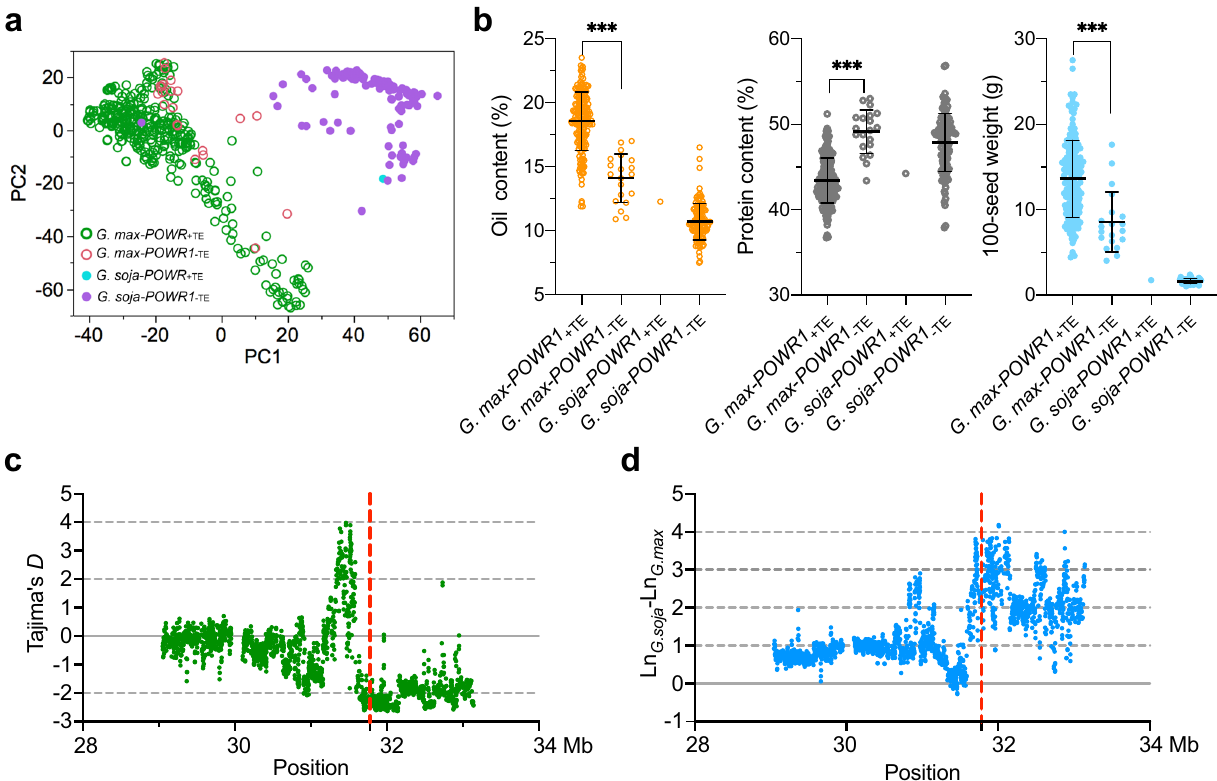
Fig. 4 Distribution and diversity analysis of POWR1 alleles in soybean. a PCA of 548 cultivated and wild soybean accessions with different allele types is shown. b Comparison of seed oil and protein content and 100-seed weight of G. max and G. soja accessions carrying POWR1 + TE or POWR1 − TE ( n = 377; 21, 1,149). Statistical signi fi cance was determined by two-tailed unpaired Student ’ s t test. * p < 0.05, ** p < 0.01, and *** p < 0.001. Unpaired t -test p values = <0.0001, 0.2775 for oil content; <0.0001, 0.2823 for protein content; <0.0001, 0.7034 for seed weight. Trait values are shown as the mean ± SD. c , d Tajima ’ s D and Ln( π - G. soja )-Ln( π - G. max ) between G. max and G. soja accessions across the 4.1 Mb region containing POWR1 . The vertical solid red line indicates the physical position of POWR1 . Source data are provided as a Source Data fi